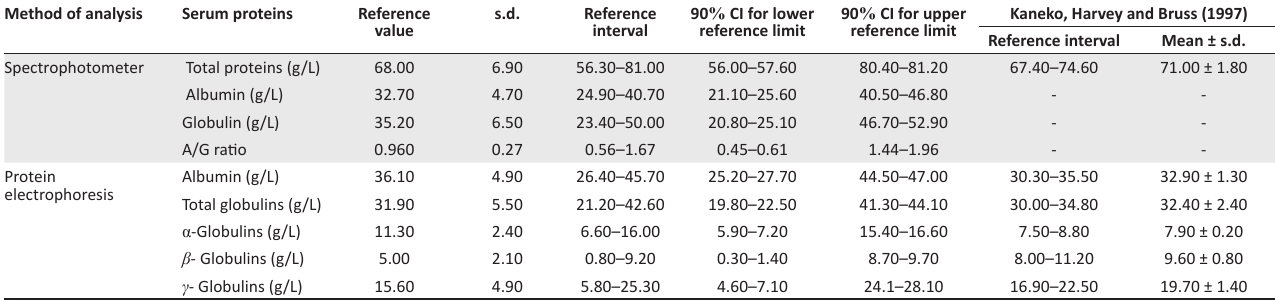
TABLE 1: Reference intervals for serum proteins in buffalo heifers measured both by spectrophotometer and electrophoresis. Method of analysis